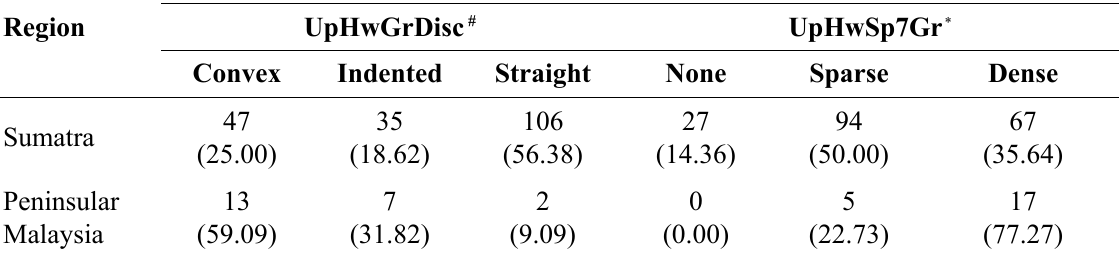
Table 7. Numbers and percentages (in parentheses) of males with each categorical character from Sumatra and Peninsular